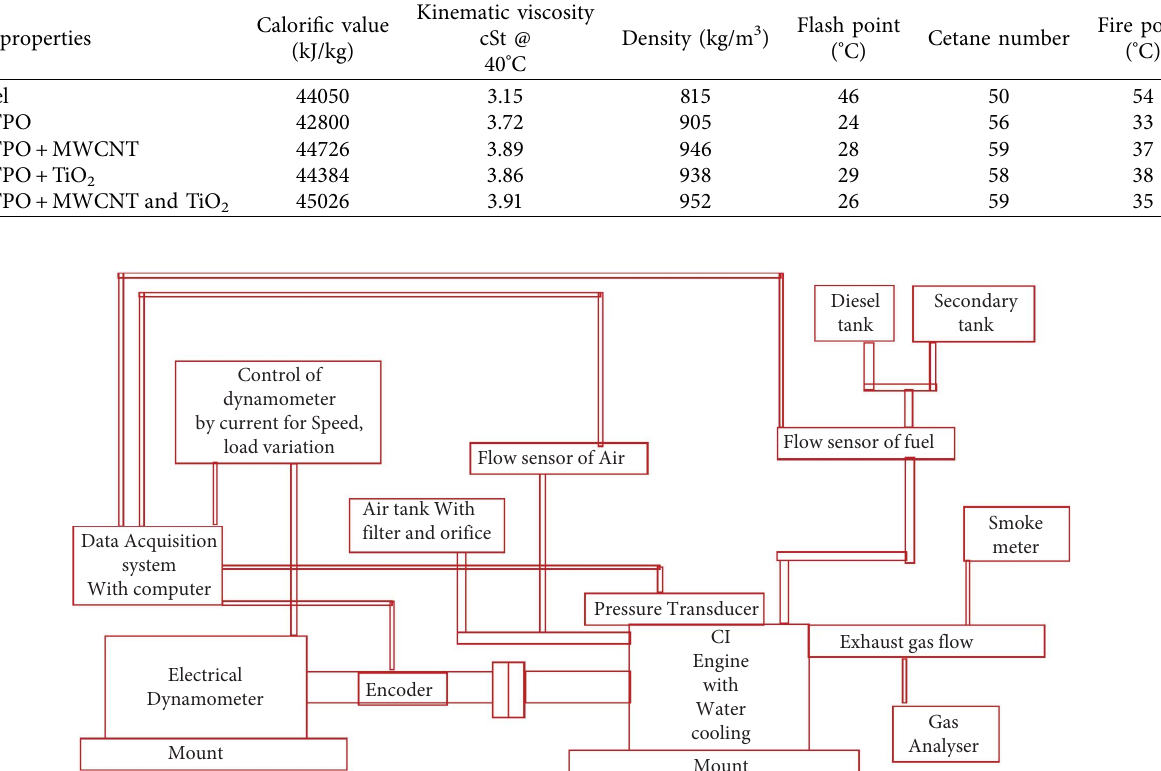
Figure 4: Experimental